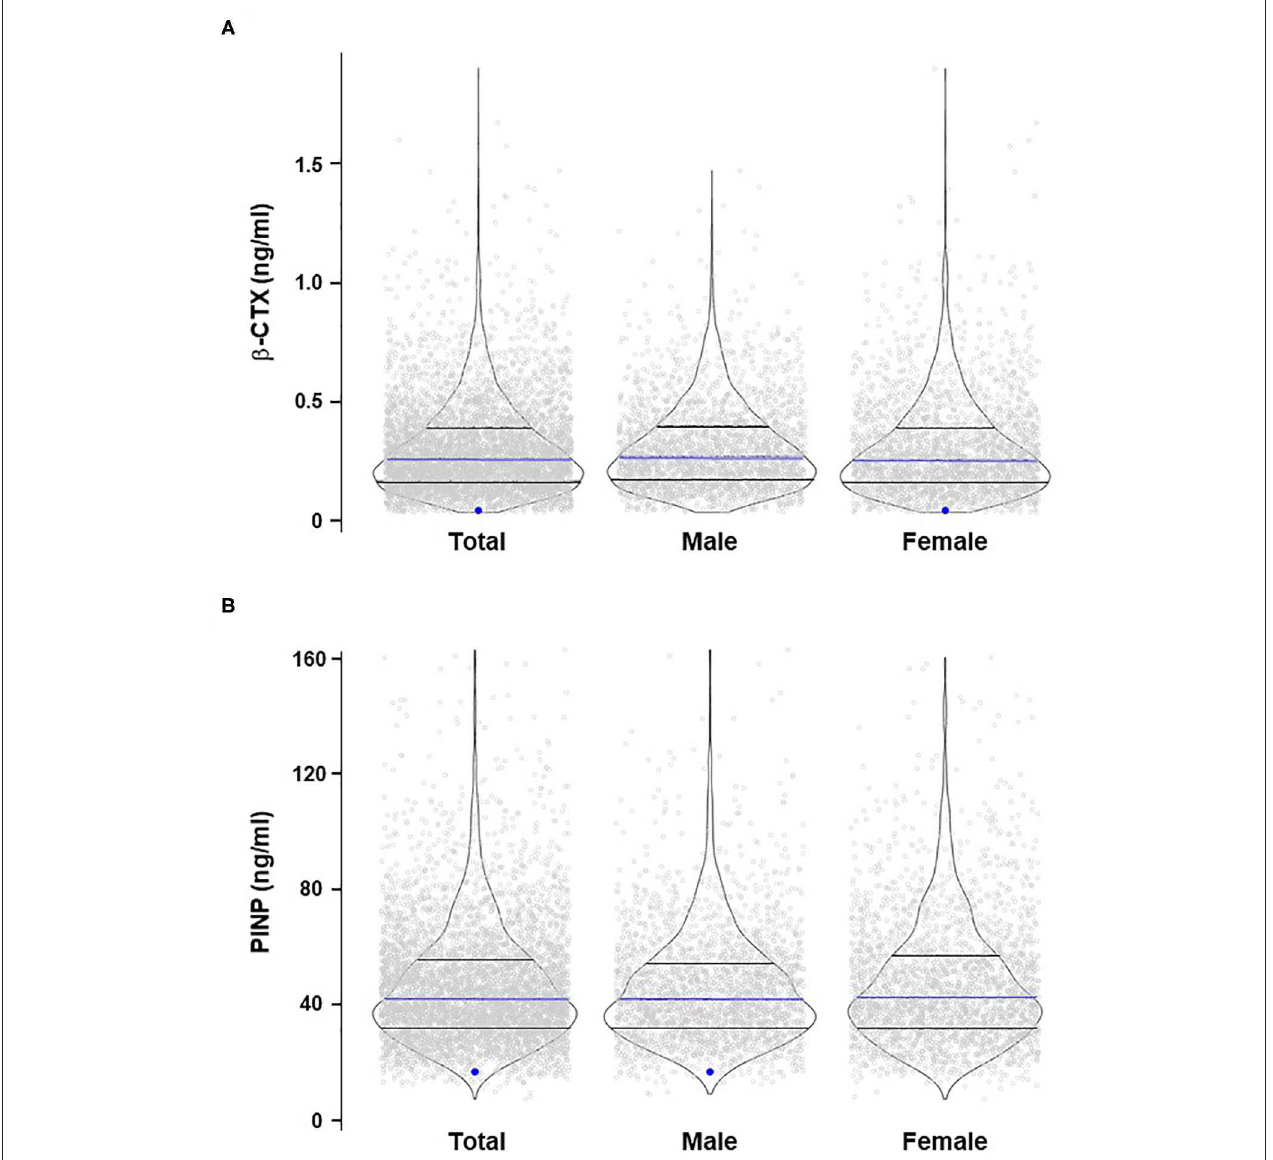
FIGURE 1 | Violin plots of β -CTX (A) and PINP (B) distribution in the study cohort stratified for sex. The blue dots indicate the heterozygous samples with significant associations between rs200498139 and β -CTX (A) and rs3737458 and PINP (B) . The blue lines indicate the median values; lower and upper black lines indicate the 1st and 3rd quartiles,